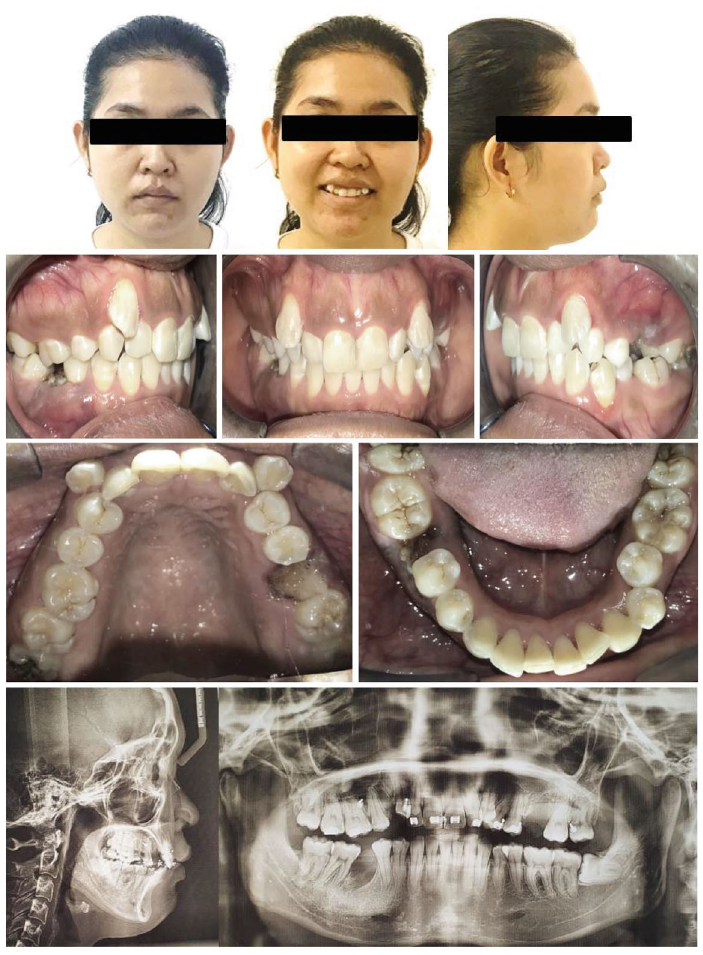
Figure 1: Pretreatment records with radiographs. Table 1: Cephalometric